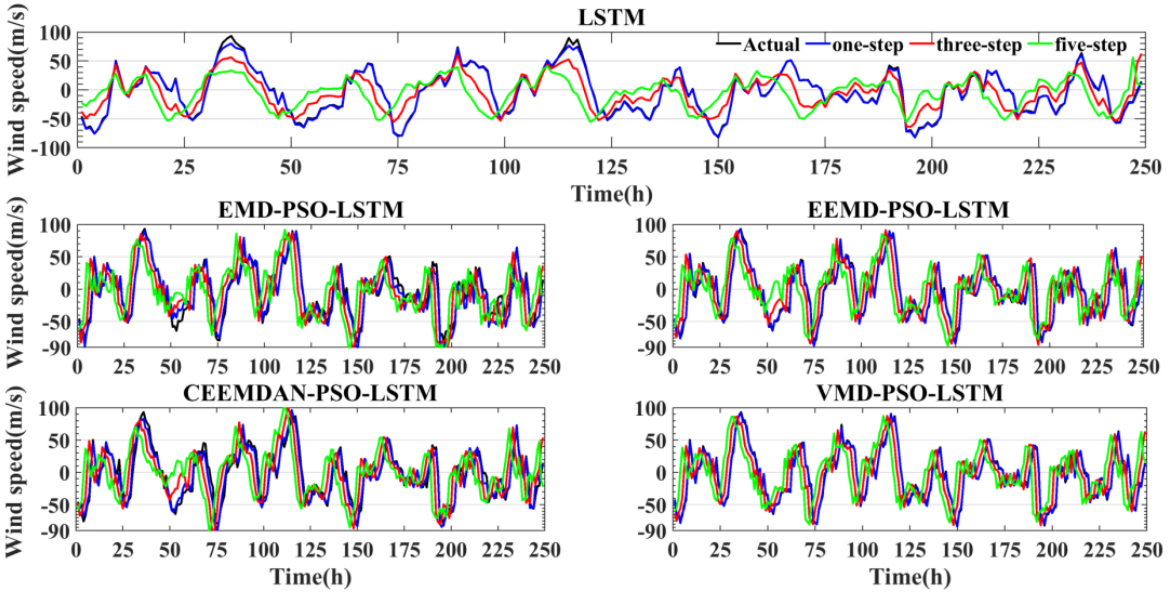
Figure 8. Comparison results of different decomposition prediction models (14 – 23 June 2019), observations (black line), one-step predicted value (blue line), three-step predicted value (red line) and five-step predicted value (green line).